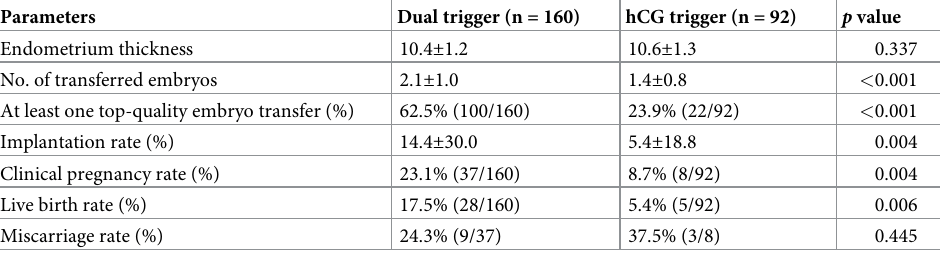
Data are presented as mean ± standard deviation and